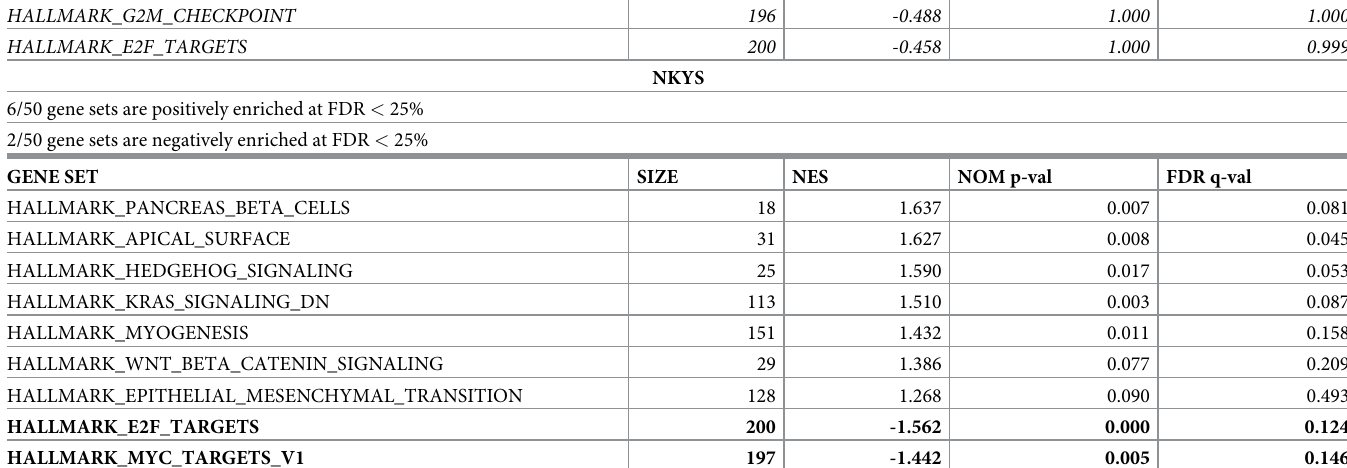
Table 2. Gene set enrichment analysis of siZAP-70 vs siNT in HANK-1, NKYS and SNK-1 NKTL cell lines [Hallmark gene set analysis].